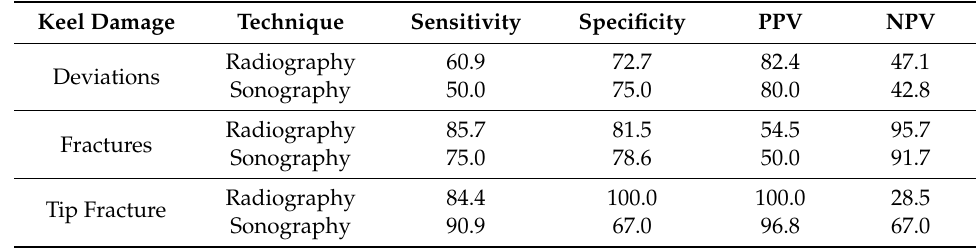
Table 4. The sensitivity (%), specificity (%), positive predictive value (PPV, %), and negative predictive value (NPV, %) of radiography and sonography in detecting keel bone deviations, fractures, and tip